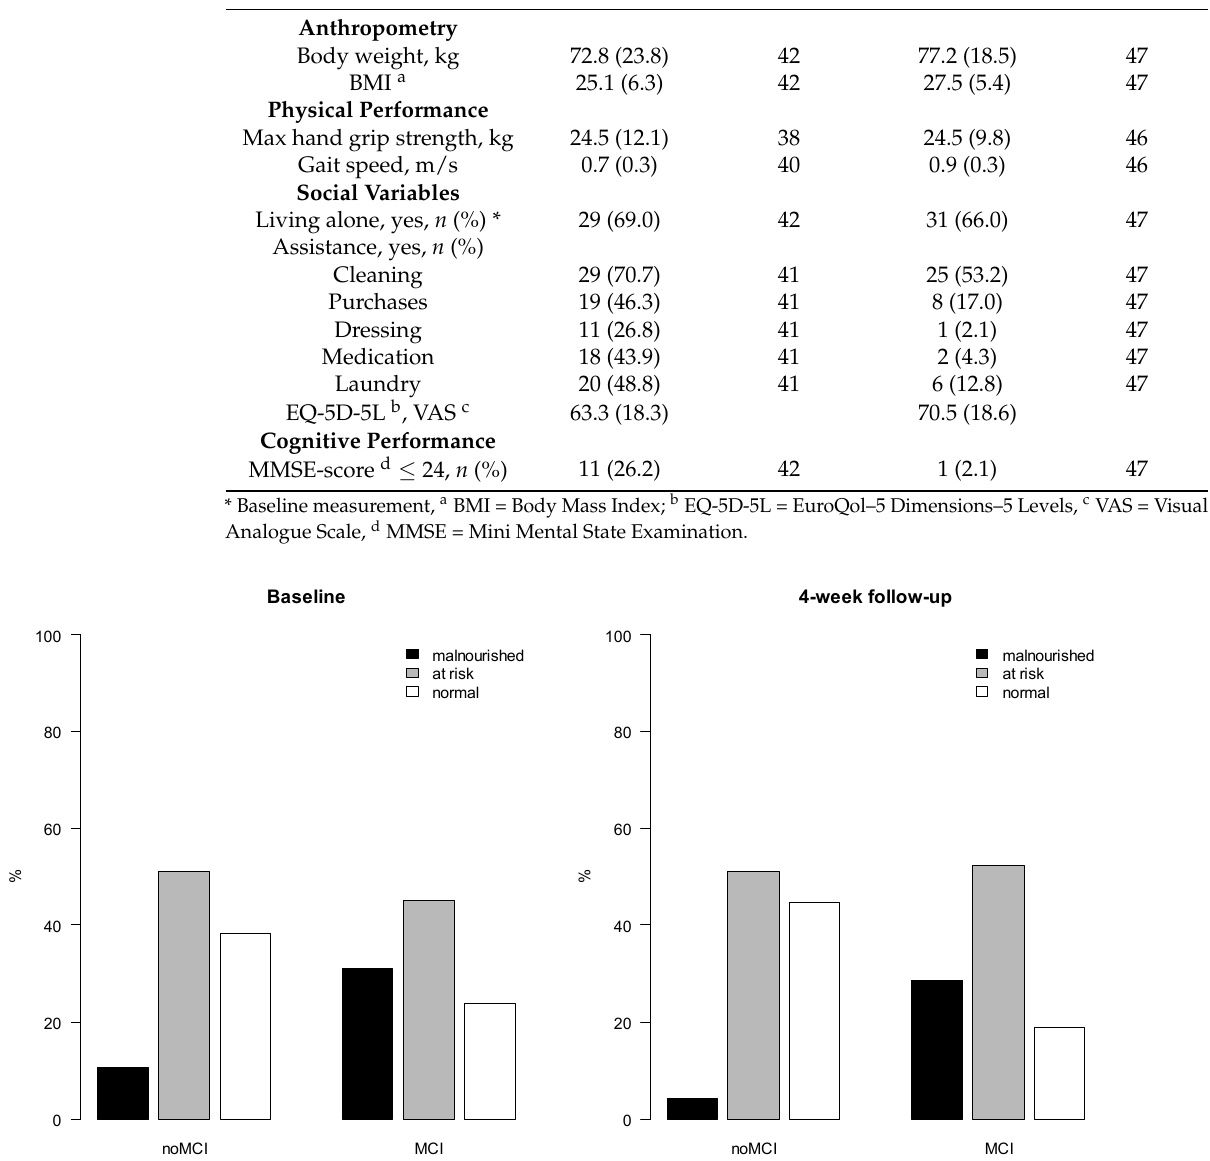
Figure 2. The prevalence of malnutrition and risk of malnutrition (assessed with MNA-SF) at baseline and 4-week follow-up for participants with mild cognitive impairment (MCI) and participants with intact cognition (noMCI). Notes to Figure 2: Malnourished = malnutrition (MNA-SF score 0–7); risk = risk of malnutrition (MNA-SF score of 8–11); normal = normal nutritional status (MNA-SF score 12–14); noMCI = intact cognition; MCI = mild cognitive impairment.